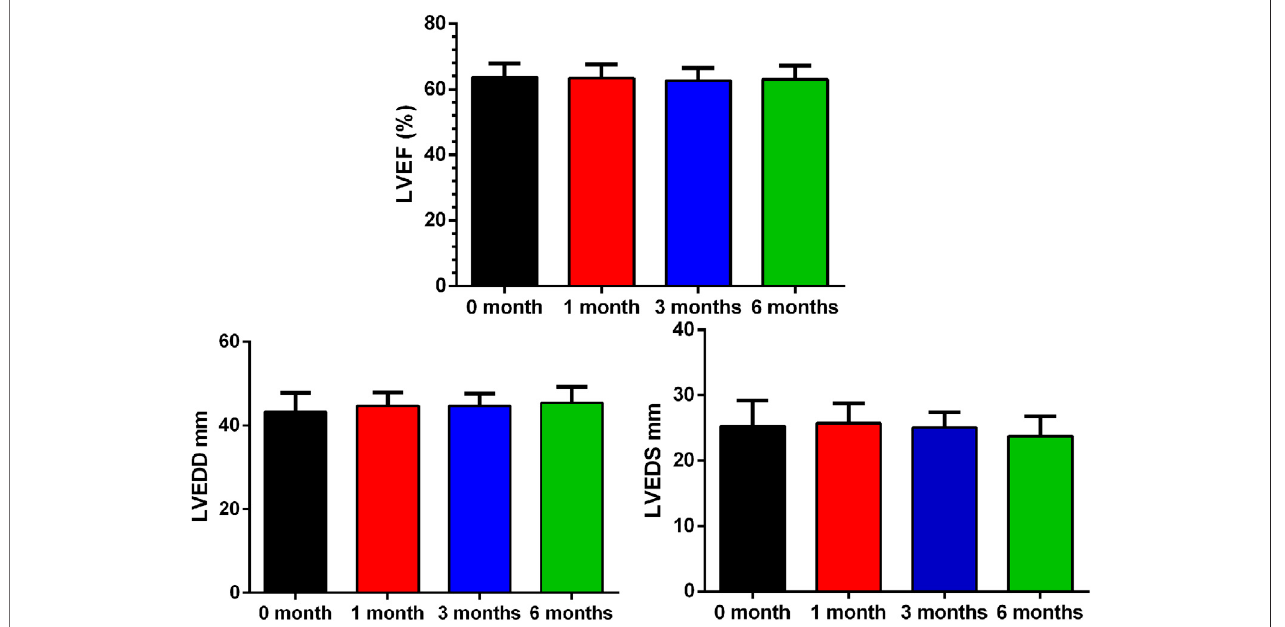
FIGURE 1 | Baseline and Interval Changes in Echocardiography. LVEF: left ventricular ejection fraction; LVEDD: left ventricular end diastolic diameter.